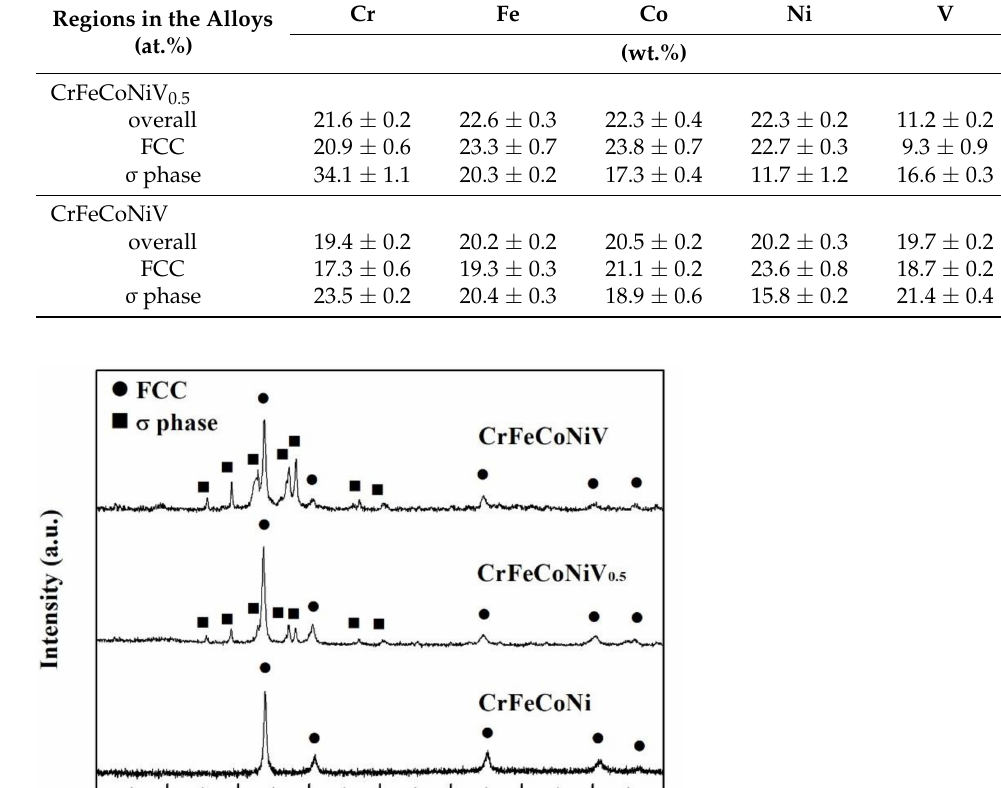
Table 2. Chemical compositions of as-cast CrFeCoNiV x alloys and the phases in the alloys (analyzed by SEM/EDS).